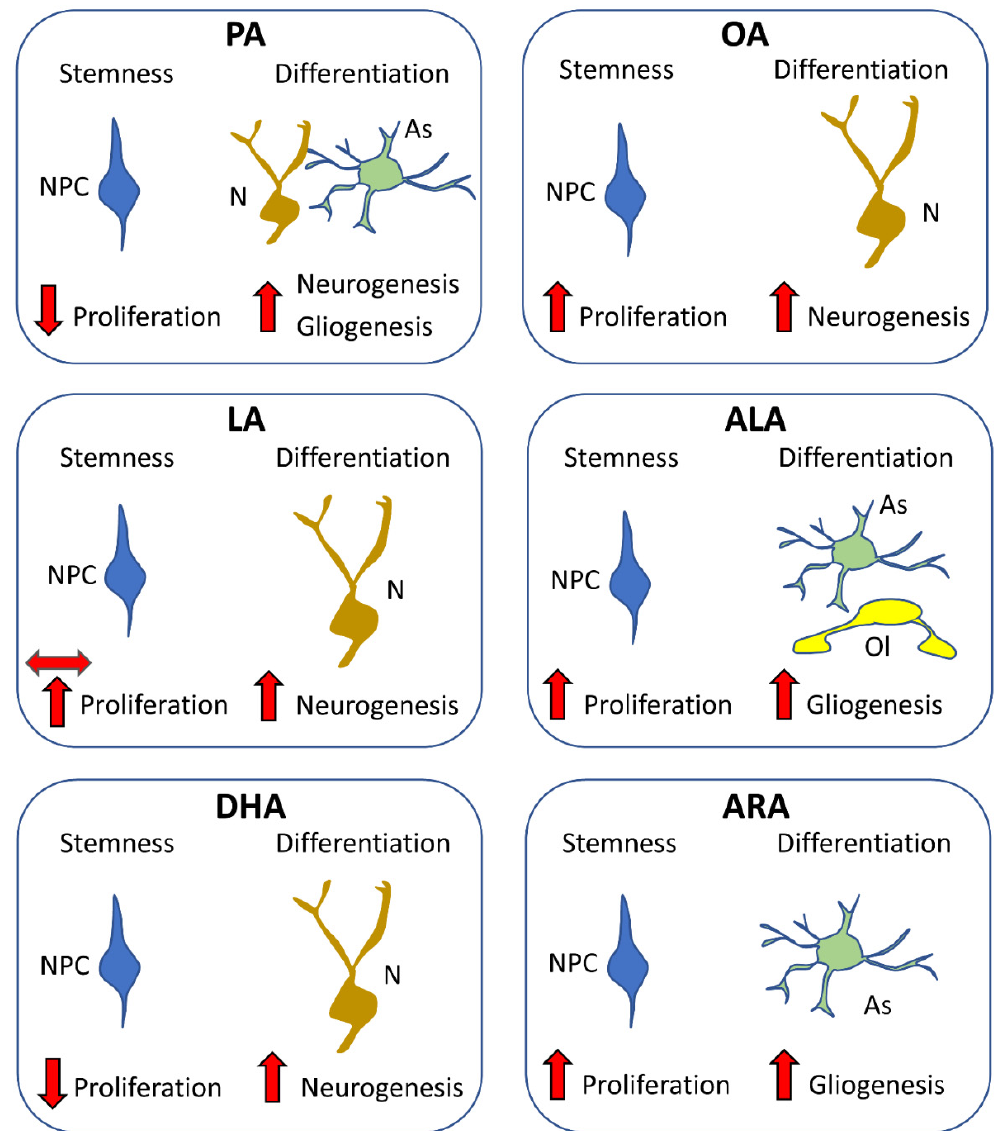
Figure 4. Summary of the effects of fatty acids on neurogenesis . Abbreviations: ALA, α -linolenic acid; ARA, arachidonic acid; As, astrocyte; DHA, docosahexaenoic acid; LA, linoleic acid; N, neuron; NPC, neural progenitor cell; OA, oleic acid; OL, oligodendrocyte; PA, palmitic acid. The double-headed horizontal arrow means no effect. The upward pointing arrow indicates an increase. The downward pointing arrow indicates a reduction. The double-headed horizontal arrow means no effect.